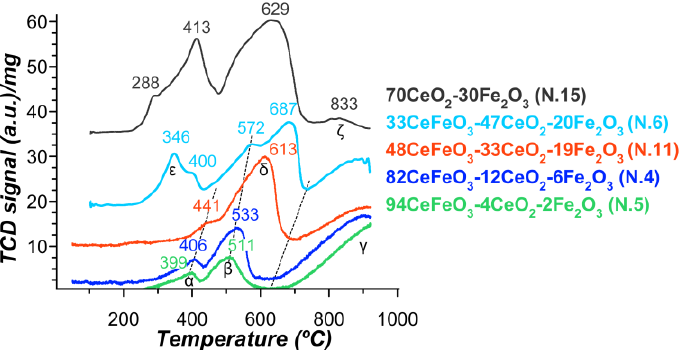
Figure 7. Temperature-programmed reduction (TPR) spectra of the SCS-products calcined at 330–350 ◦ C. Table 4. H 2 -TPR results and cell parameters for studied in TPR